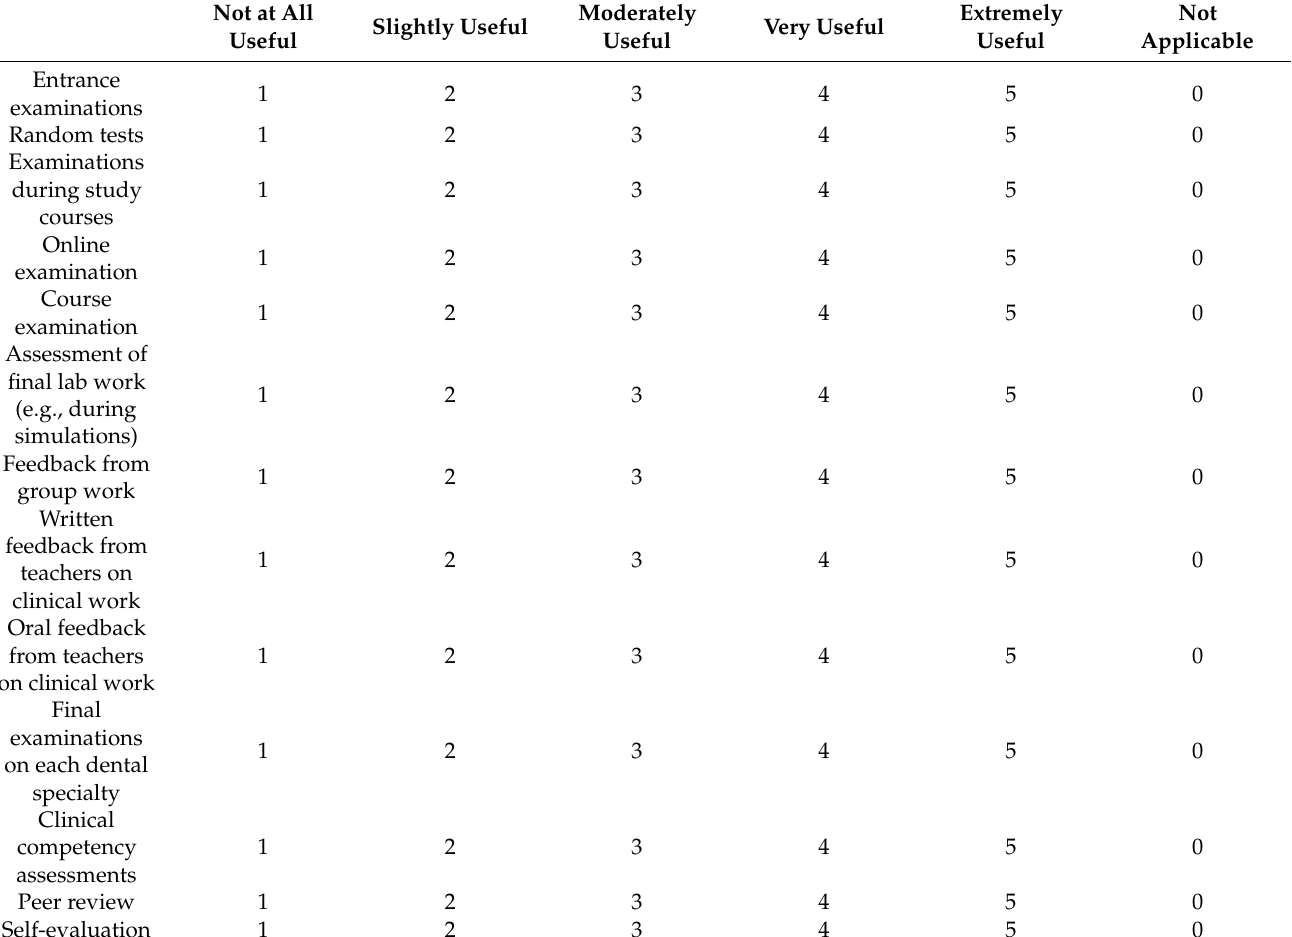
Table A6. VI Assessment methods. Evaluate how different assessment methods support your learning. Circle the option “Not applicable” if you have not participated in the learning